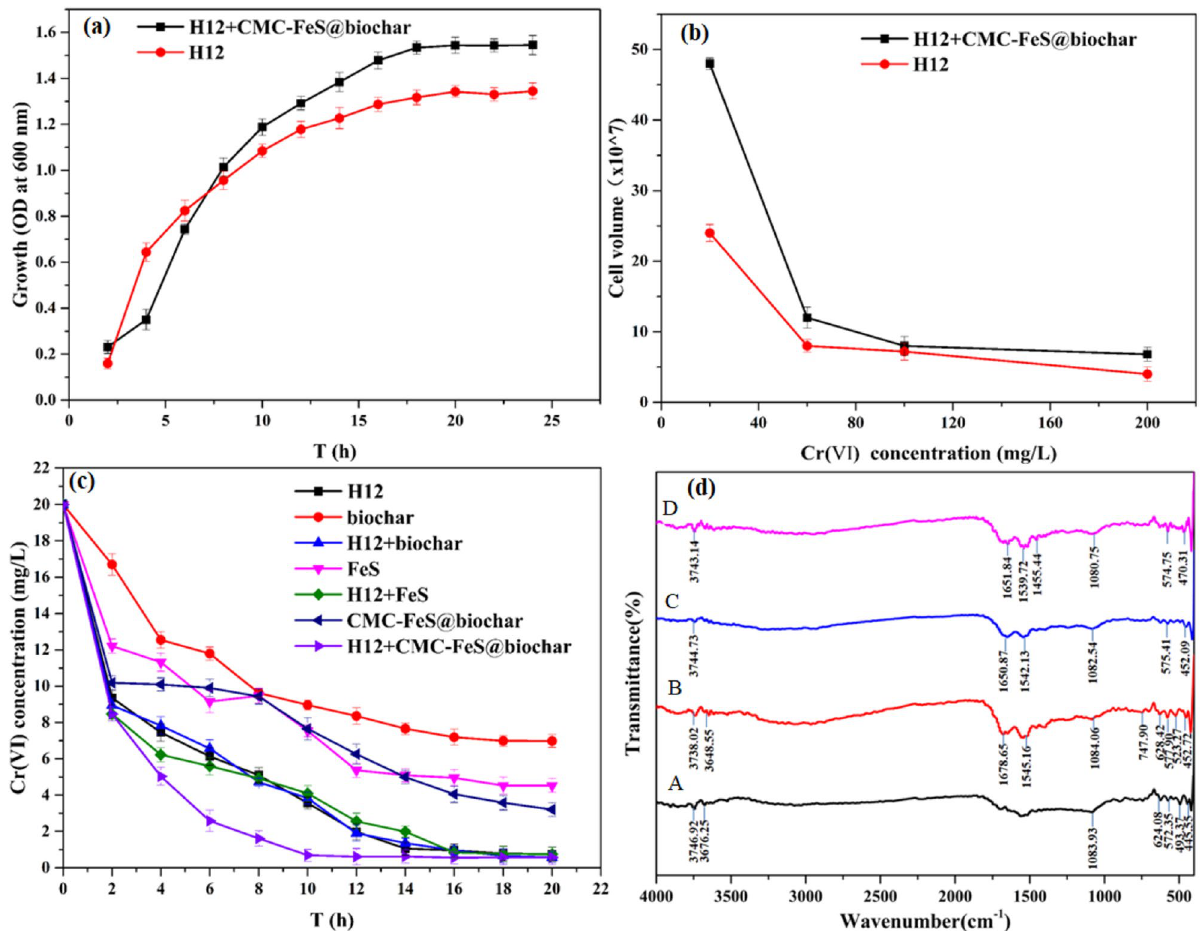
Figure 3. ( a ) Effect of CMC-FeS@biochar, ( b ) Cr(VI) concentration on the growth of K. variicola H12 in LB medium for 24 h. Experimental conditions: growth determined by cell turbidity measured at 600 nm. ( c ) Cr(VI) removal efficiency of H12, biochar, H12 + biochar, FeS, H12 + FeS, CMC-FeS@biochar, H12 + CMC-FeS@ biochar. Experimental conditions: Cr(VI) concentration 20 mg L −1 , solution volume 100 mL, and reaction time 24 h. ( d ) FTIR spectra of (A)CMC-FeS@biochar and compound of K. variicola H12 and CMC-FeS@biochar being treated with 20 mg L −1 Cr(VI) under different periods (B) 4th, (C) 10th, (D) 16th h, respectively. All the above experiments are carried out at pH